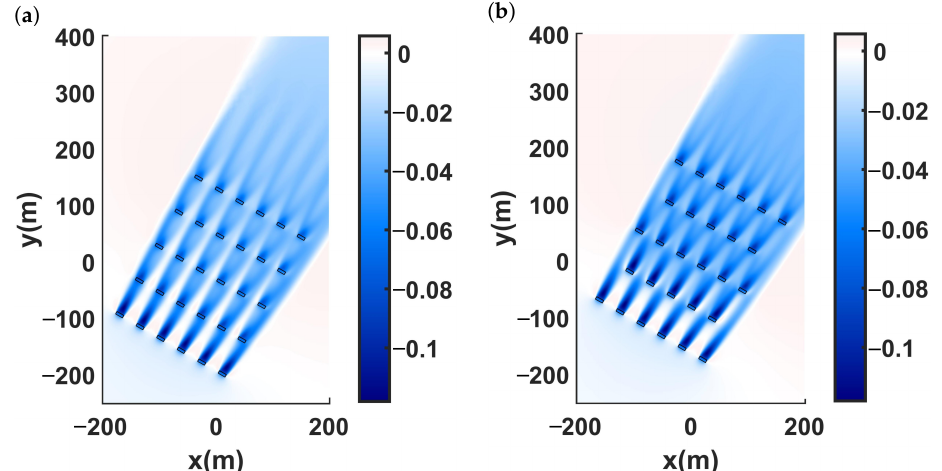
Figure 12. ( a ) Aligned arrangement and ( b ) staggered arrangement: difference in velocity magnitude with and without blockage corrections (in m/s). The results were extracted along a horizontal plane (located at the hub height) at peak flood of a mean spring tidal cycle (the seabed is